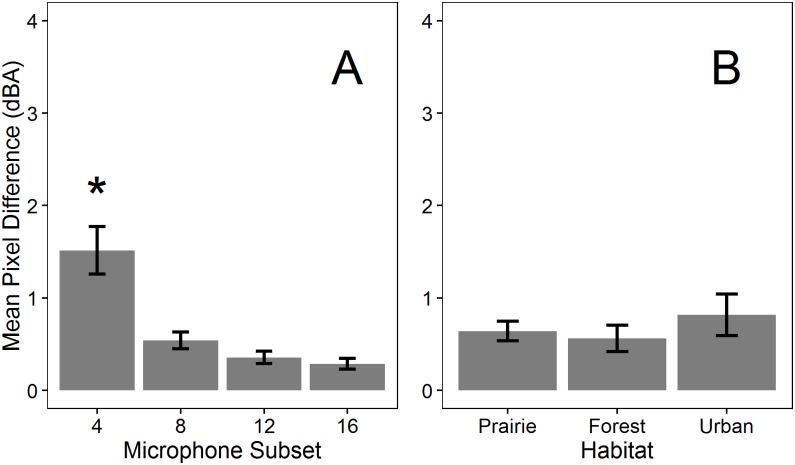
Map differences of ambient conditions varied with microphone number (A) but not across habitats (B).Mean pixel difference is the average difference in overall sound pressure levels (dBA) calculated by subtracting a subset map from the corresponding full array map and averaging overall all pixels. The asterisk denotes a significant difference as tested using Tukey HSD (P < 0.05). Error bars represent standard error.